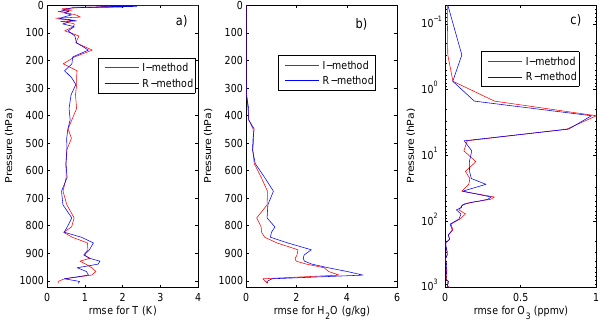
= 0 . 8 cm). t O for the two retrieval 2